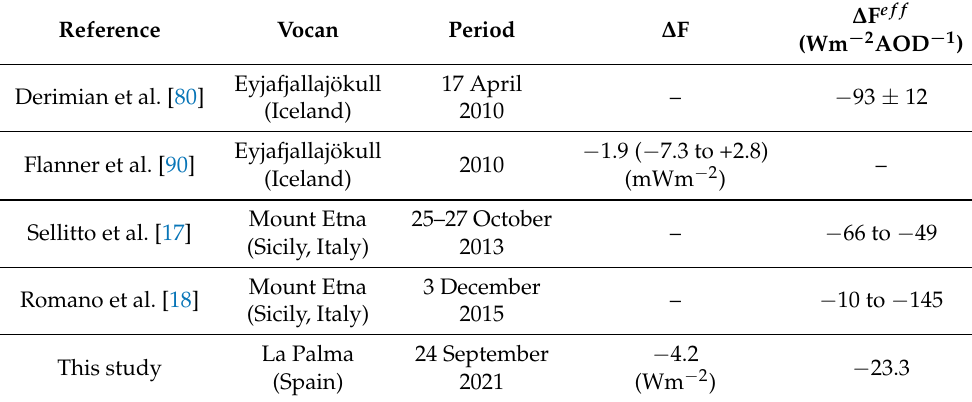
Table A2. Summary of diurnally averaged radiative forcing efficiency at the surface obtained by previous studies during volcanic